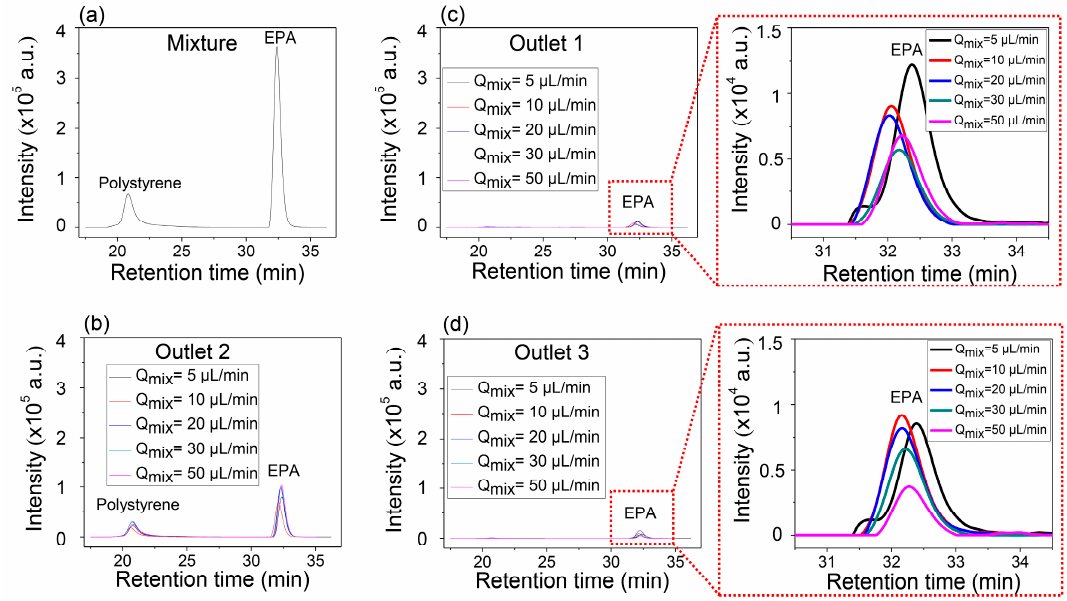
Figure 5. Selective continuous separation of ethyl phenylacetate (EPA) from the mixture of EPA with PS using GPC: ( a ) GPC analysis of the mixture; ( b ) GPC analysis of Outlet 2; ( c ) GPC analysis of Outlet 1; ( d ) GPC analysis of Outlet 3 for the different inlet flow rates.